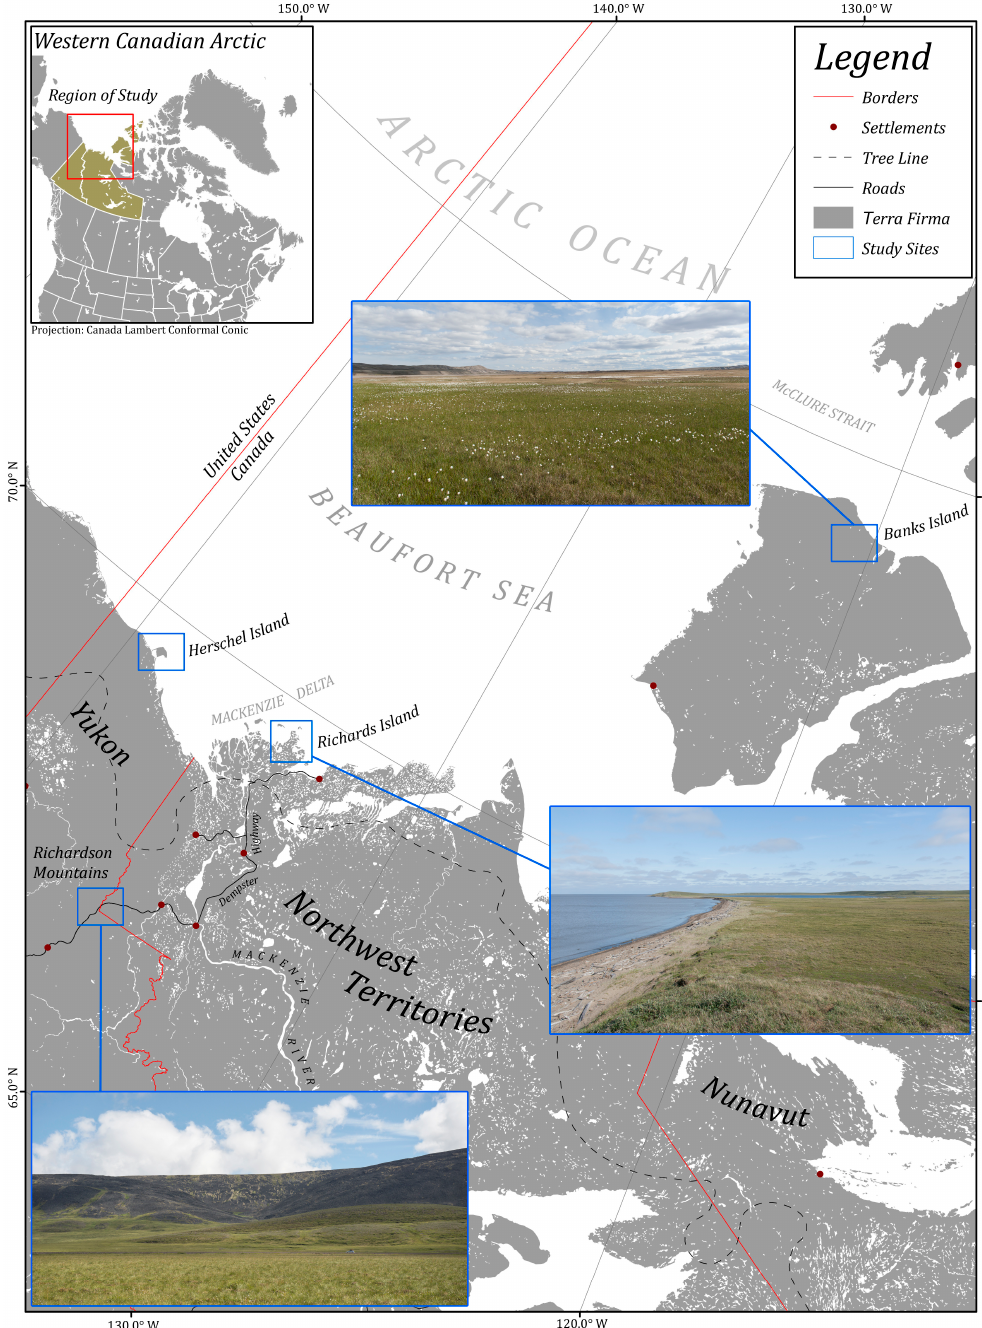
Figure 1. Map of the study sites situated within the Western Canadian Arctic. Map created from Atlas of Canada National Scale Data 1:1,000,000 [85] and Northern Geodatabase [86]. Scale bar is approximate, given that scale is variable with conical projections. Photographs of ground conditions are shown for Banks Island (top), Richards Island (middle), and Richardson Mountains (bottom).